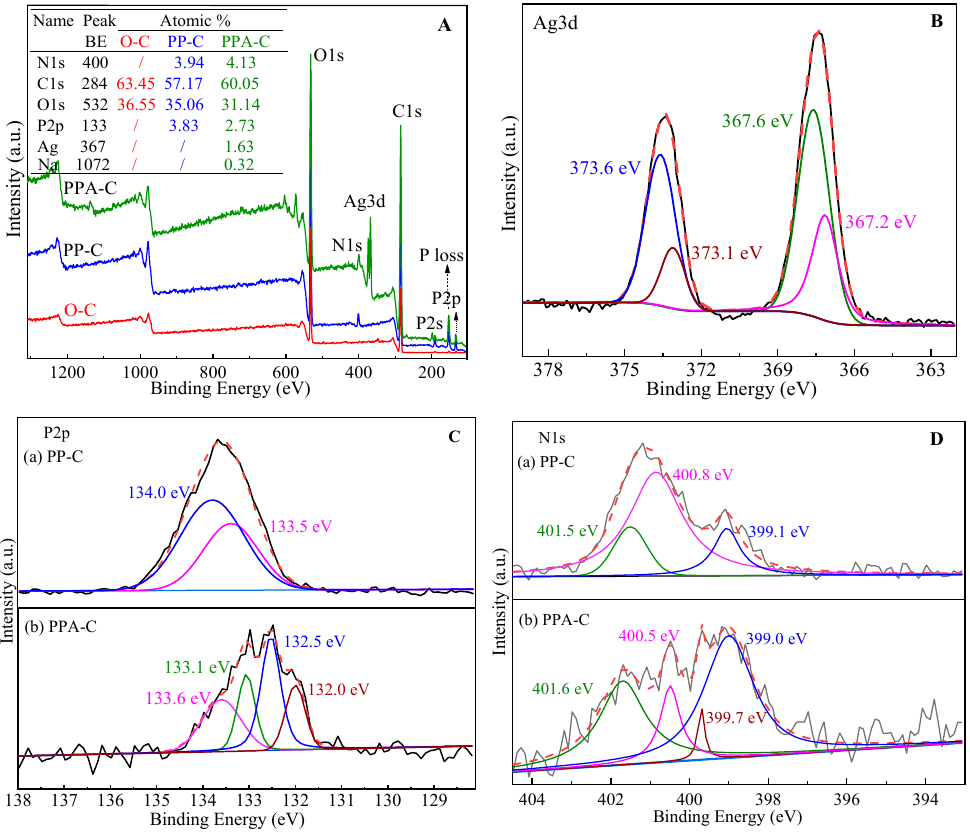
Figure 4. XPS spectrum of fabrics (( A ): surface elements of fabric before and after finishing; ( B – D ): morphology of Ag, P, N elements on the surface of finished fabrics).